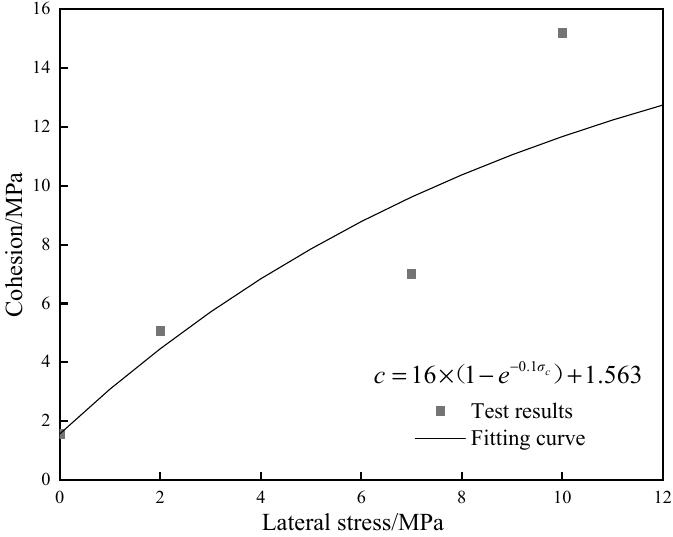
Figure 16. Comparison of the test and fitting results of the relationship between cohesion and lateral stress.